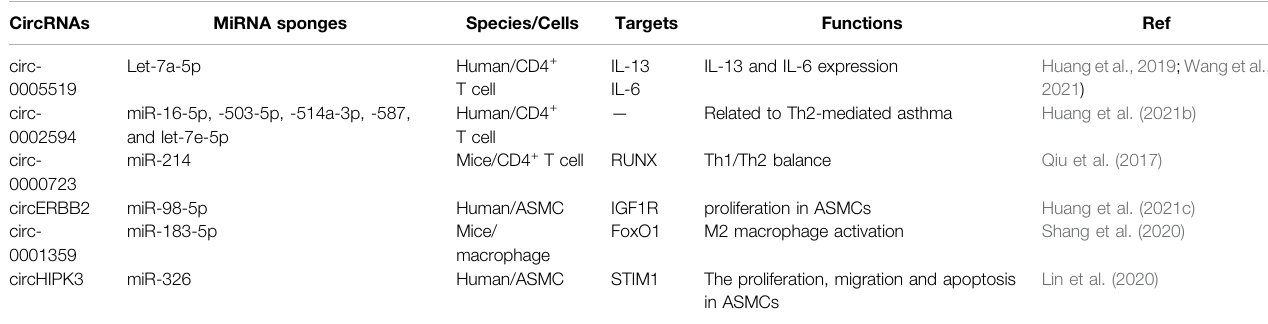
TABLE 4 | Roles of circRNAs in childhood